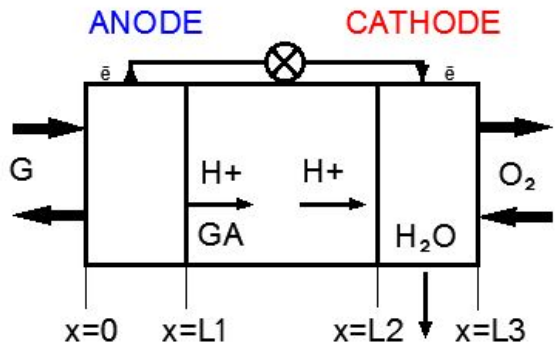
Figure 4. Schematic representation of the membraneless MFC.